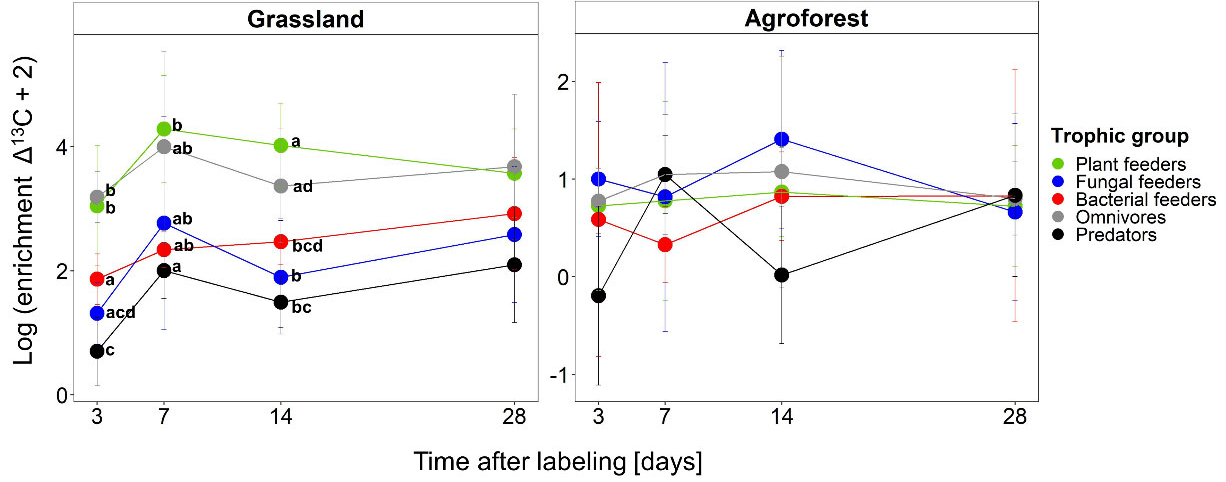
Figure 2. Enrichment with 13 C [(log( ∆ 13 C + 2) in‰ ± s.d.] of nematode trophic groups at 3, 7, 14 and 28 days after 13 CO 2 labeling of grass and willow. Values with no or the same letter are not significantly different according to Tukey’s HSD test at p < 0.05. Letters denote significant differences between ∆ 13 C between the nematode trophic groups for each sampling day.